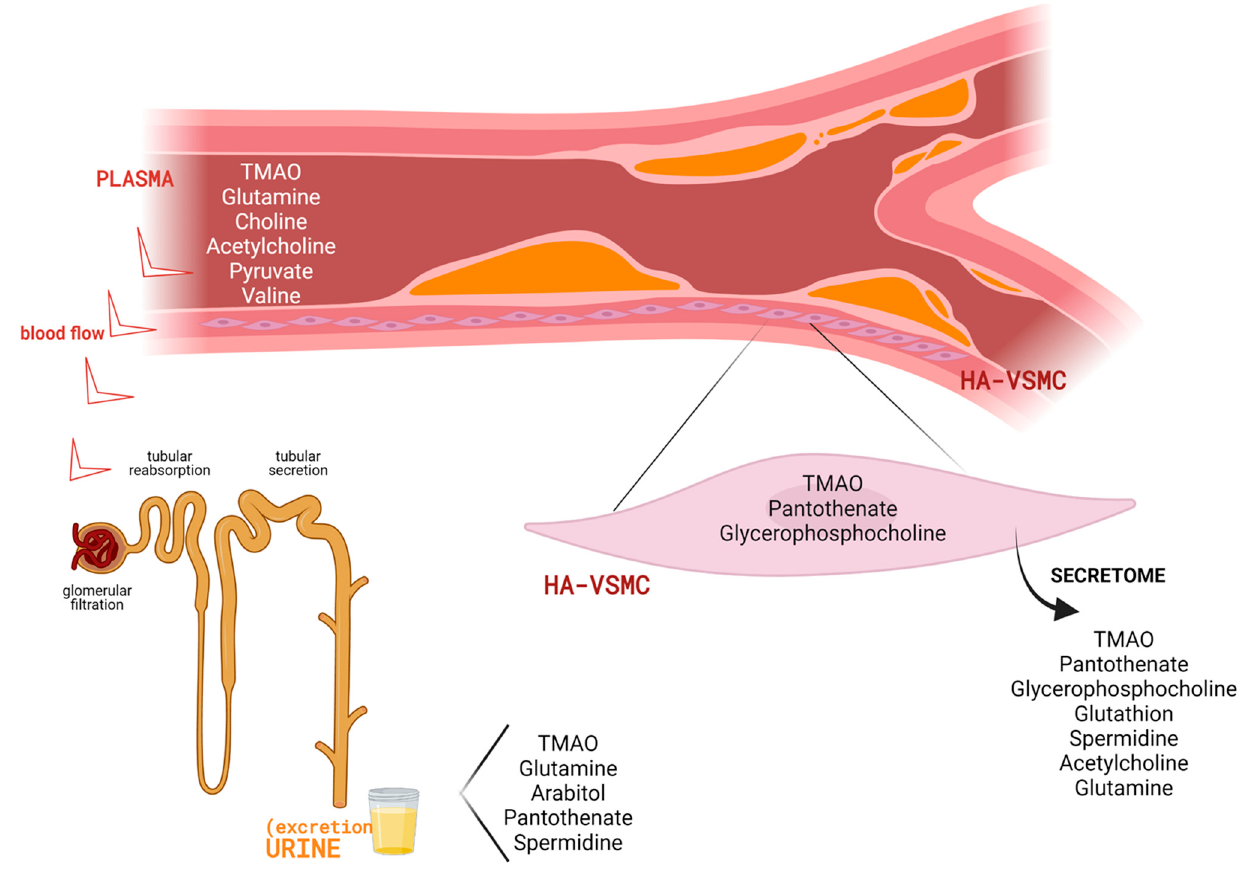
Figure 4. Overview of metabolic alterations identified in association with CVrisk and atherosclerosis development. Specifically, changes were observed in urine and plasma from subjects with programmed CABG surgery, and in the intracellullar and extracellular (secretome) content of human aortic VSMCs (HA-VSMCs) after exposure to a pro-atherosclerotic stimulus. Created with BioRender.com (accessed on 29 July 2021).